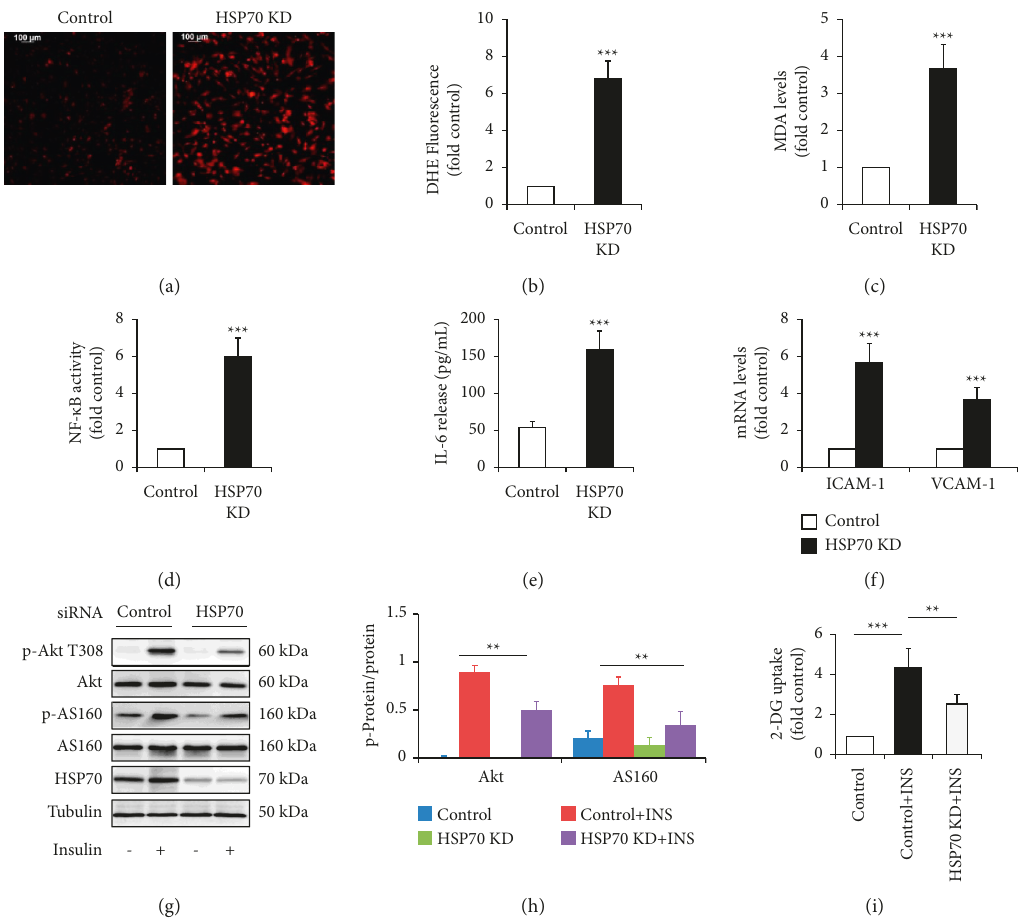
Figure 4: Effect of HSP70 knockdown (KD) on endothelial function. The siRNA technique was used to silence HSP70 in HUVECs. The cells were then grown in NG (5.5mM glucose) media for 36h. To observe the effect of Nar on insulin signaling, the cells were treated with or without 100nM of insulin for 10min. (a) Effect of HSP70 KD on ROS formation by DHE staining. (b) Quantification of relative DHE fluorescence in (a). (c) Effect of HSP70 KD on intracellular MDA concentration. (d) Effect of HSP70 KD on NF- κ B activity. (e) Effect of HSP70 KD on IL-6 concentration in the culture media. (f) Effect of HSP70 KD on mRNA levels of cell adhesion molecules ICAM-1 and VCAM-1. (g) Effect of HSP70 KD on insulin-stimulated phosphorylation of Akt and its downstream AS160. (h) Quantification of phosphorylated Akt and AS160 in (g). (i) Effect of HSP70 KD on insulin-stimulated 2-DG uptake. Data are expressed as means ± SD ( n � 3). ∗∗ P < 0 . 01 and ∗∗∗ P < 0 . 001 versus siRNA control group or the indicated